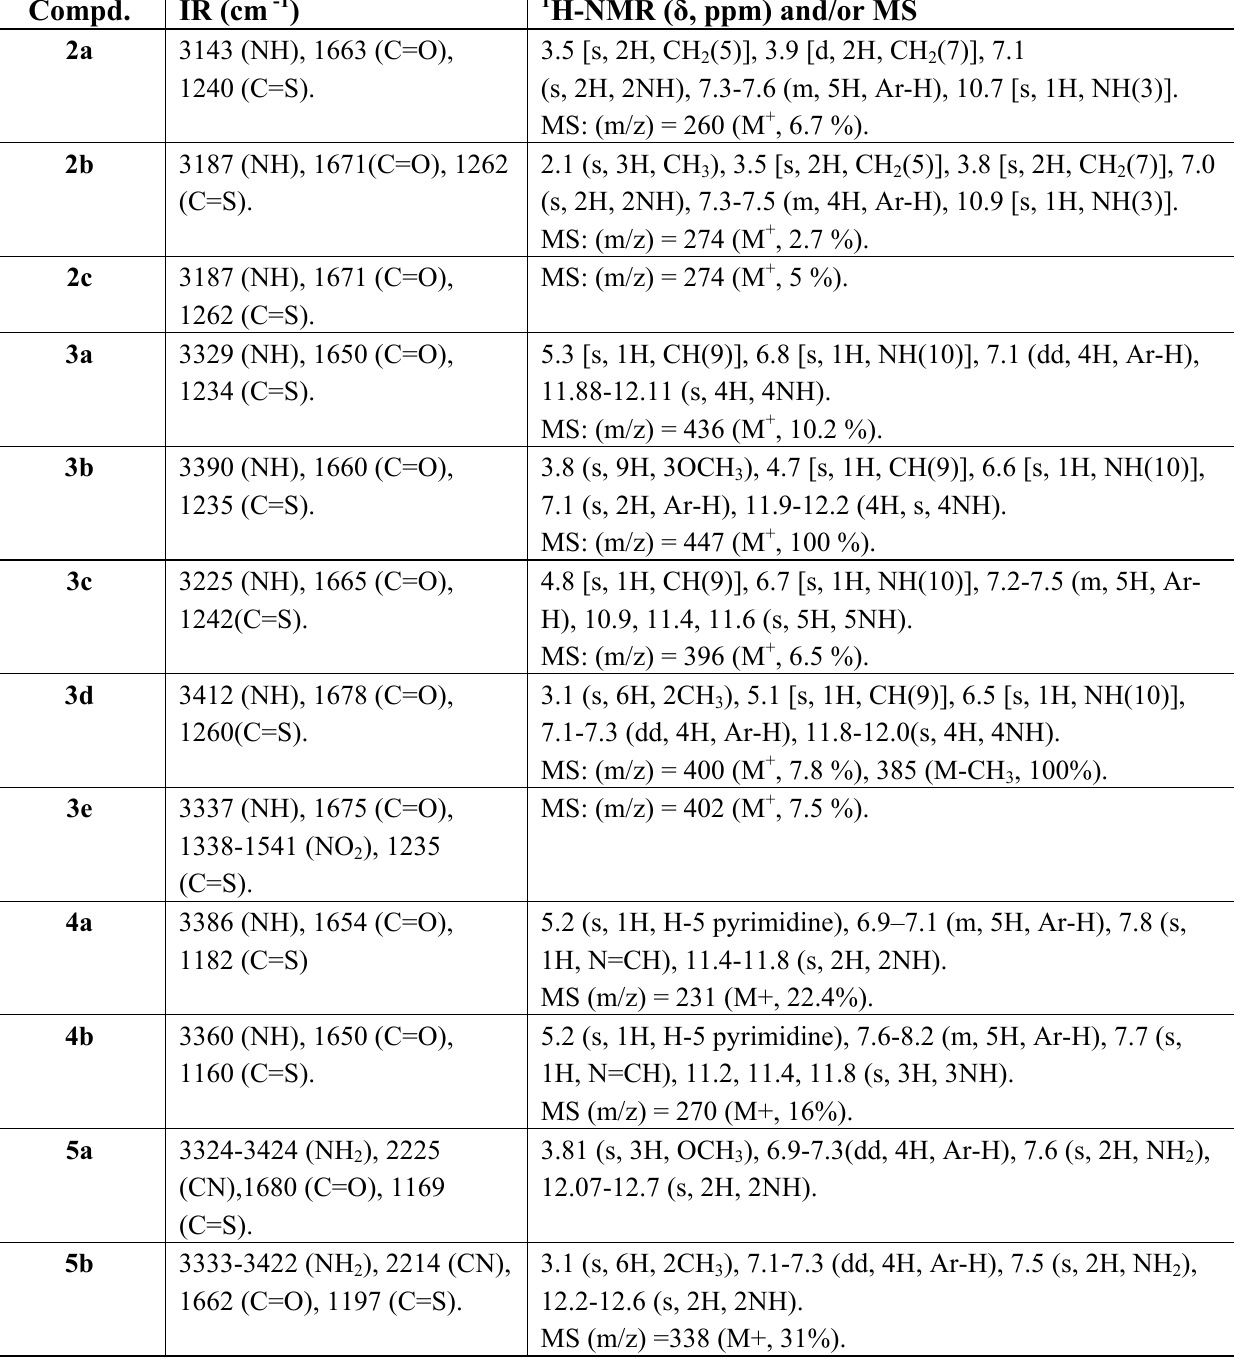
Table 4. IR, 1 H-NMR, and MS of the new